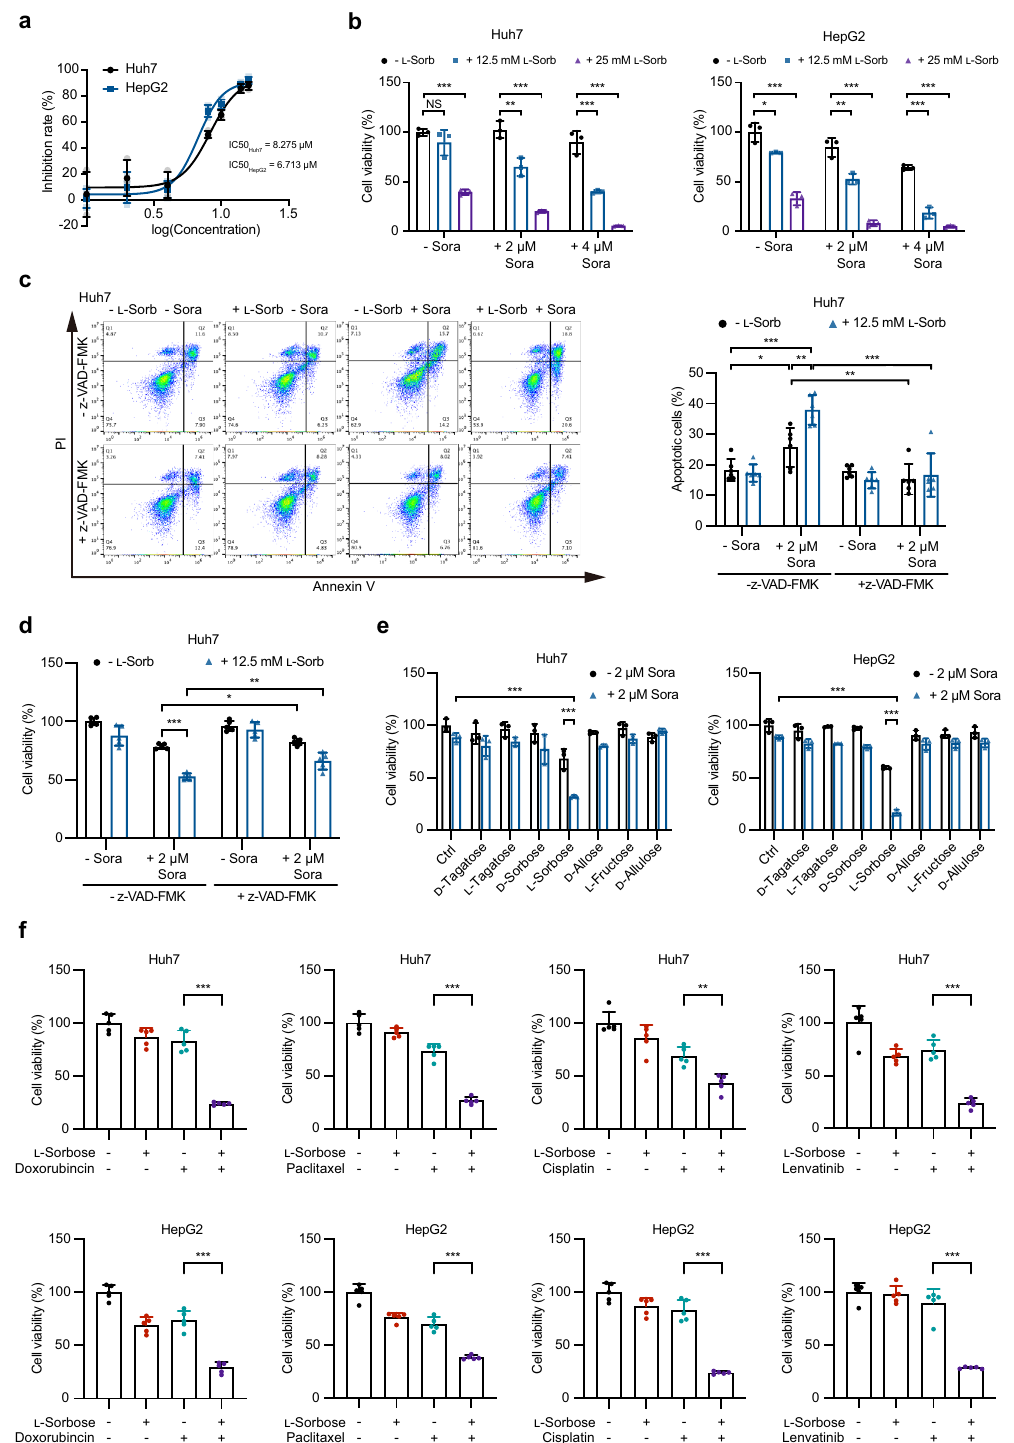
Fig. 3 L -Sorbose enhances antitumor activity of sorafenib in vitro. a , Huh7 or HepG2 cells were incubated with various concentrations of sorafenib for 24 h, and their viability rates were measured and IC50s were calculated. n = 3. b , Cells treated with L -sorbose (0, 12.5 or 25 mM) were incubated with sorafenib (0, 2 or 4 μ M) for 24 h, and cell viability rates were measured. n = 3. c , Huh7 cells were treated with or without 12.5 mM L -sorbose, 2 μ M sorafenib, and 50 μ M z-VAD-FMK for 24 h. The levels of apoptosis were measured. Left panels: Representative dot plots. Right panels: Quanti fi cation of the ratio of apoptotic cells. n = 6. d , Huh7 cells were treated with or without 12.5 mM L -sorbose, 2 μ M sorafenib, and 50 μ M z-VAD-FMK for 24 h, and cell viability was measured. n = 5. e , Huh7 and HepG2 cells were treated by 2 μ M sorafenib in combination with different rare sugars (25 mM) for 24 h, and their viabilities were measured. n = 3. f , Viabilities of cells treated with L -sorbose and other drugs. The concentrations of drugs used in this assay were as follows: cisplatin, 50 μ M; doxorubicin, 100 nM; lenvatinib, 2 μ M; paclitaxel, 1 μ M. n = 5. Data are presented as the mean ± s.d. and were analyzed by unpaired two-tailed Student ’ s t test or two-way ANOVA with Dunnett ’ s test. * P < 0.05, ** P < 0.01, *** P < 0.001. NS, not signi fi